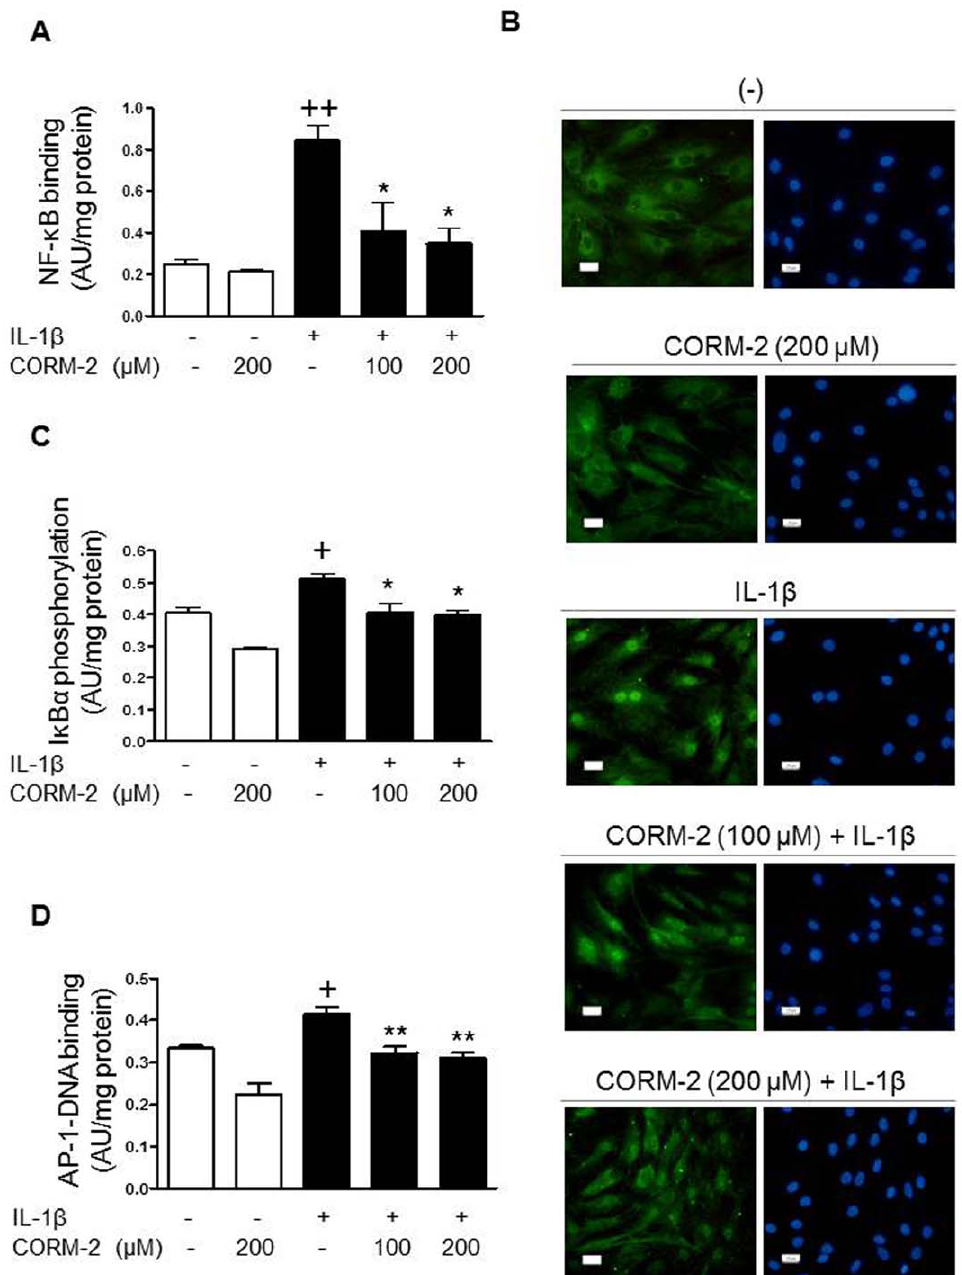
Figure 10. Effect of CORM-2 on NF- k B and AP-1 activation in OA synoviocytes. (A) NF- k B binding to DNA, (B) NF- k B p65 translocation (left panels: p65, right panels: DAPI), (C) I k B a phosphorylation and (D) AP-1 binding to DNA. Cells were stimulated with IL-1 b (10 ng/ml) for 30 min (C) or 1 h (A, B, D) with IL-1 b (10 ng/ml) in the presence or absence of CORM-2 (100, 200 m M). I k B a phosphorylation and NF- k B/AP-1 binding to DNA were determined by ELISA in cytosolic and nuclear fractions respectively, whereas p65 translocation was analyzed by immunofluorescence. Original magnification x400. Data are expressed as mean 6 S.E.M. of independent cultures with cells from 3 different donors. AU=arbitrary units. + P , 0.05, ++ P , 0.01 with respect to nonstimulated cells. * P , 0.05, ** P , 0.01 with respect to IL-1 b